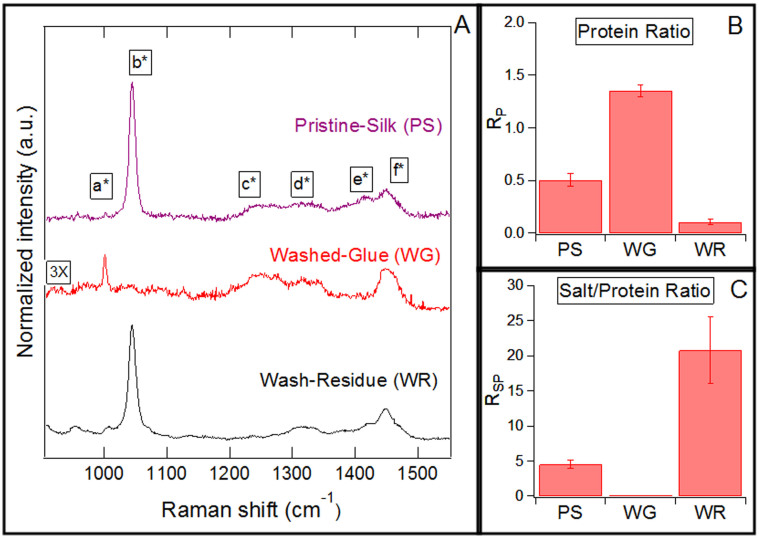
(A) Raman spectra of pristine-silk, washed-glue and wash-residue. Pristine-silk was in suspended state, while the washed-glue and wash-residue were immobilized on a CaF2 substrate. Labeled Raman peaks and their assignments are: a* - Phenylalanine32, b* - Isethionic Acid21, c* - Amide-III23, d* - Alanine32, e* - Glycine21, f* - CH3 asymmetric bend/CH2 bending32. (B) RP quantifies the spectral differences and is defined as the ratio of area of protein-specific peaks c* to the area of common peak d*. (C) RSP is the ratio of area of salt-specific peak b* to the area of protein-specific peaks c*.